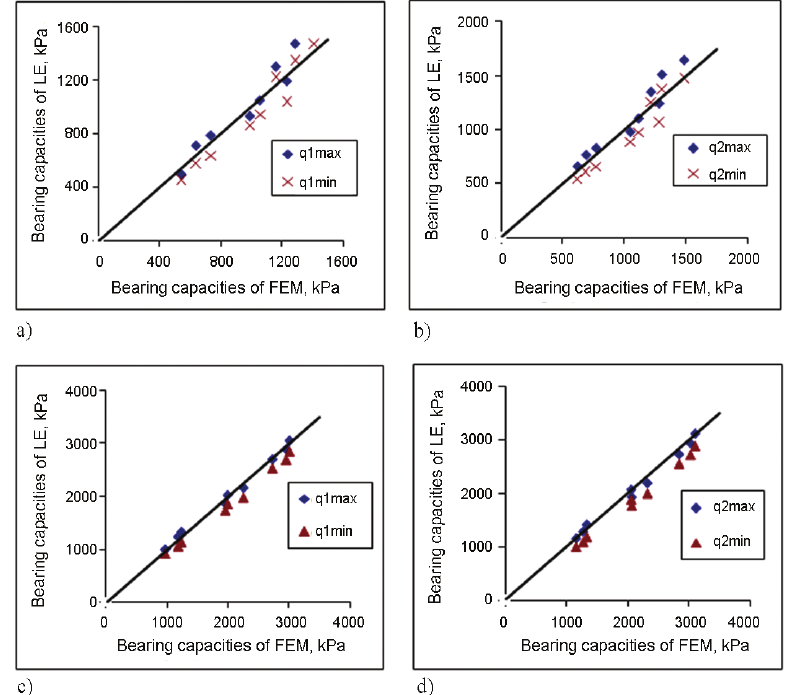
Fig. 6. Comparisons of bearing capacity obtained from FEM and the New Limit Equilibrium Approach: a) L= B and b) L/B = 2 for ϕ 1 = 34° on ϕ 2 = 31°, c) L = B and d) L/B = 2 for ϕ 1 = 39° on ϕ 2 =